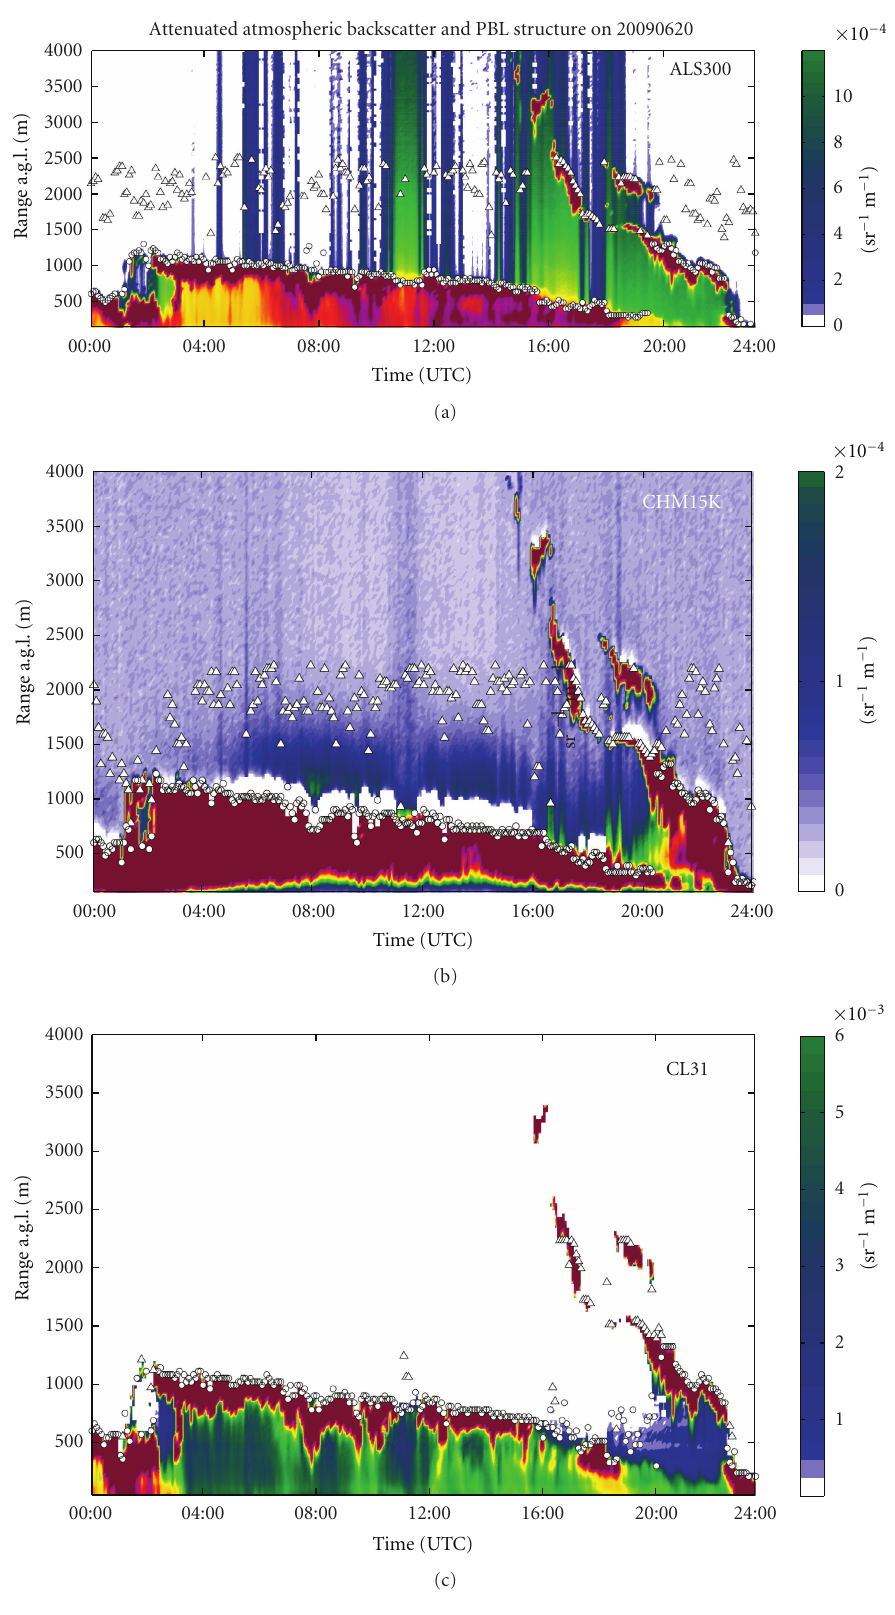
Figure 3: Time-height cross sections of the atmospheric attenuated backscatter for the 20th of June